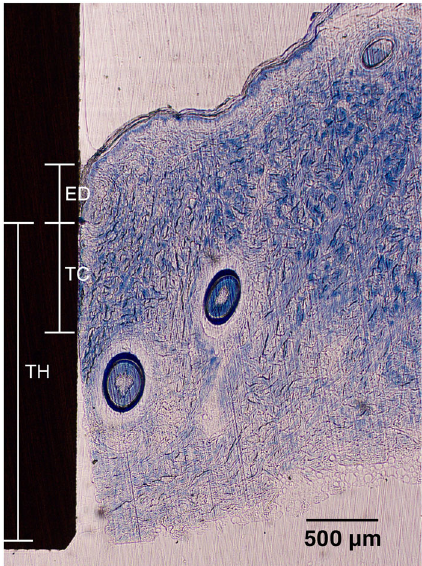
Fig. 7 Histology slides showing different cases of Epidermal Downgrowth, A The downgrowth starts at the fi rst contact point between skin and implant, B The start of the downgrowth is less de fi ned, leading to a larger measurement